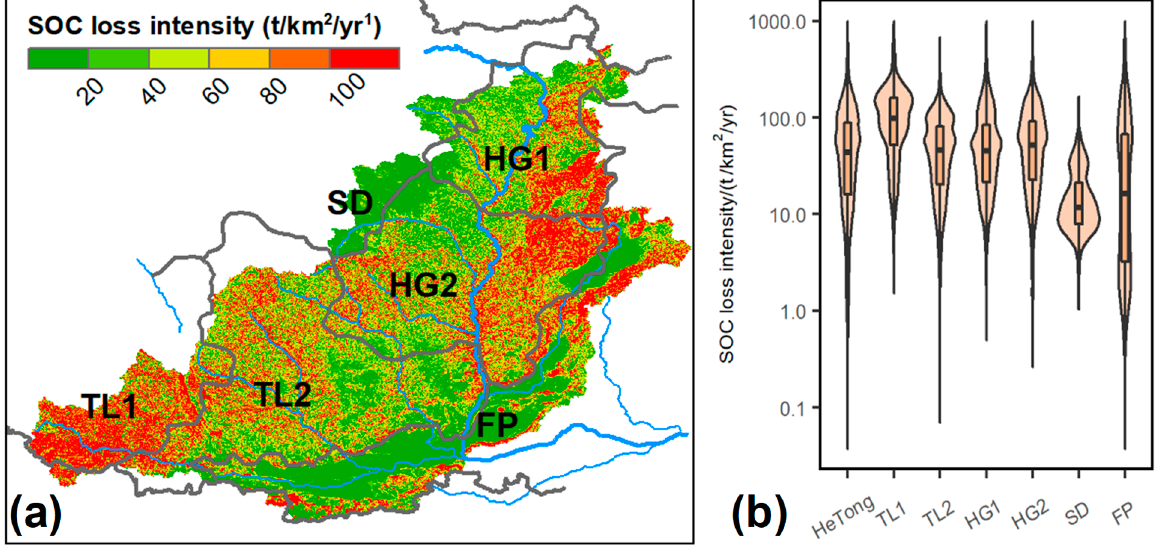
Figure 3. ( a ) Spatial distribution of SOC loss intensity in the Hetong region and ( b ) its statistical comparison in different sub-regions.